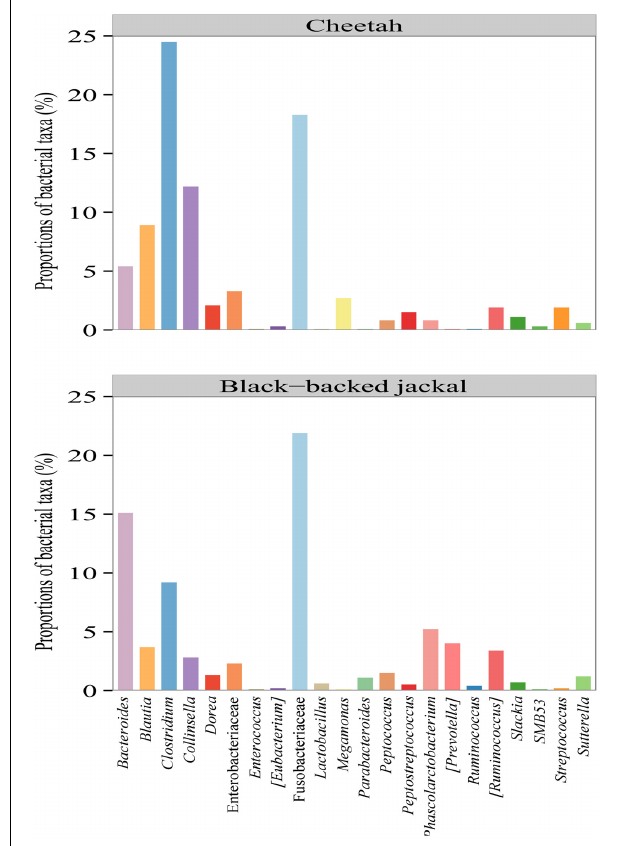
FIGURE 4 | Proportions of bacterial taxa which were present in both the cheetah and the black-backed jackal with proportions ≥ 0.1% (pooled on host species level) at the finest taxonomic resolution. Oligotyping was performed on all 20 bacterial genera and the two bacterial families to resolve the within taxon variation of bacteria between host species on a bacterial species-like level.